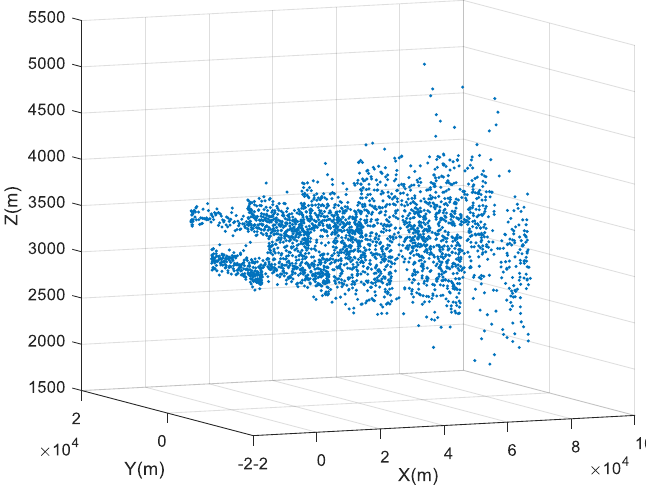
Figure 2. The relative location of two maneuvering targets at each time.